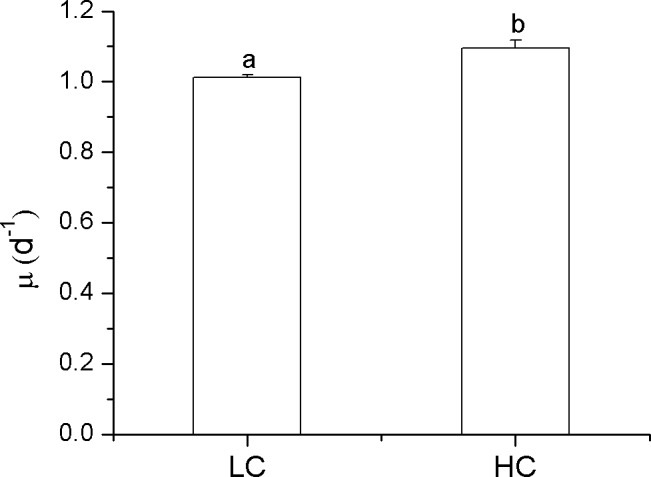
Specific growth rates of P. tricornutum.Specific growth rate (μ) of P. tricornutum cells grown at ambient (390 μatm; LC) and elevated CO2 (1000 μatm; HC) levels. Data are the means ± SD, n = 3 (triplicate cultures). Different letters above the histogram bars indicate significant differences (p<0.05) between different treatments.